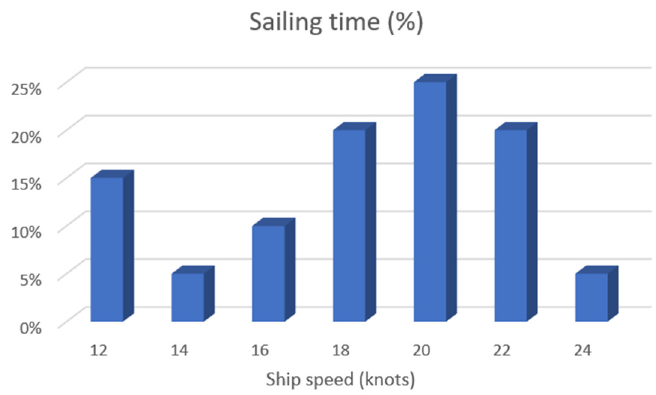
Figure 1. Example of ship speed distribution curve.